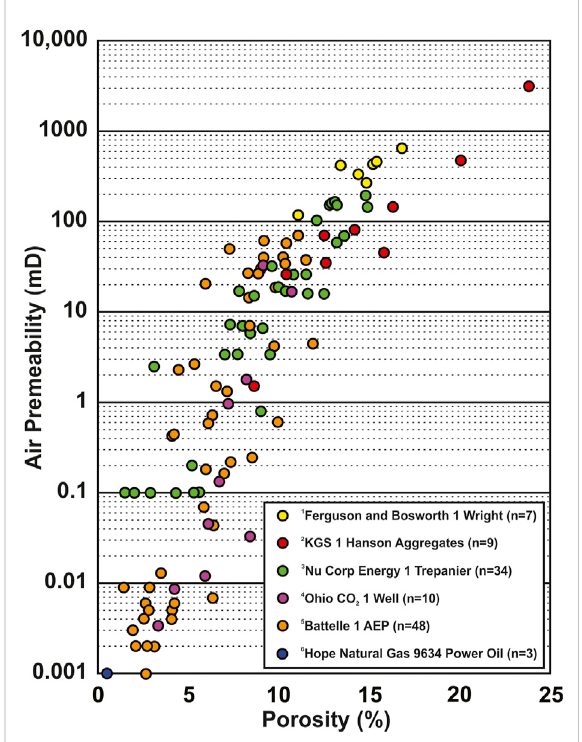
FIGURE 7 Comparison of porosity and permeability of core plugs from the Rose Run in selected wells in Kentucky, West Virginia, and Ohio. Porosity and permeability generally fall in the range for potential CO 2 storage where porosity is greater than 7%, the industry-standard cutoff for CO 2 storage (Medina et al., 2011), and 1mD permeability. Sources: Ferguson andBosworth1Wright well, KGS Oil and Gas Database, Record Number 2210; KGS 1 Hanson Aggregates well, KGS Oil and Gas Database, Record Number 143577; Nu Corp Energy 1 Trepanier well, McNealey (1991); Ohio 1 CO 2 well, Wickstrom et al. (2011); Battelle 1 AEP well, Joel Sminchak, Battelle Memorial Institute, personal communication, 24 July 2019; Hope Natural Gas 9,634 Power Oil well, Woodward (1961). Core plug locations for the Rose Run in the KGS 1 Hanson Aggregates well are shown in Bowersox et al. (2021, Figure